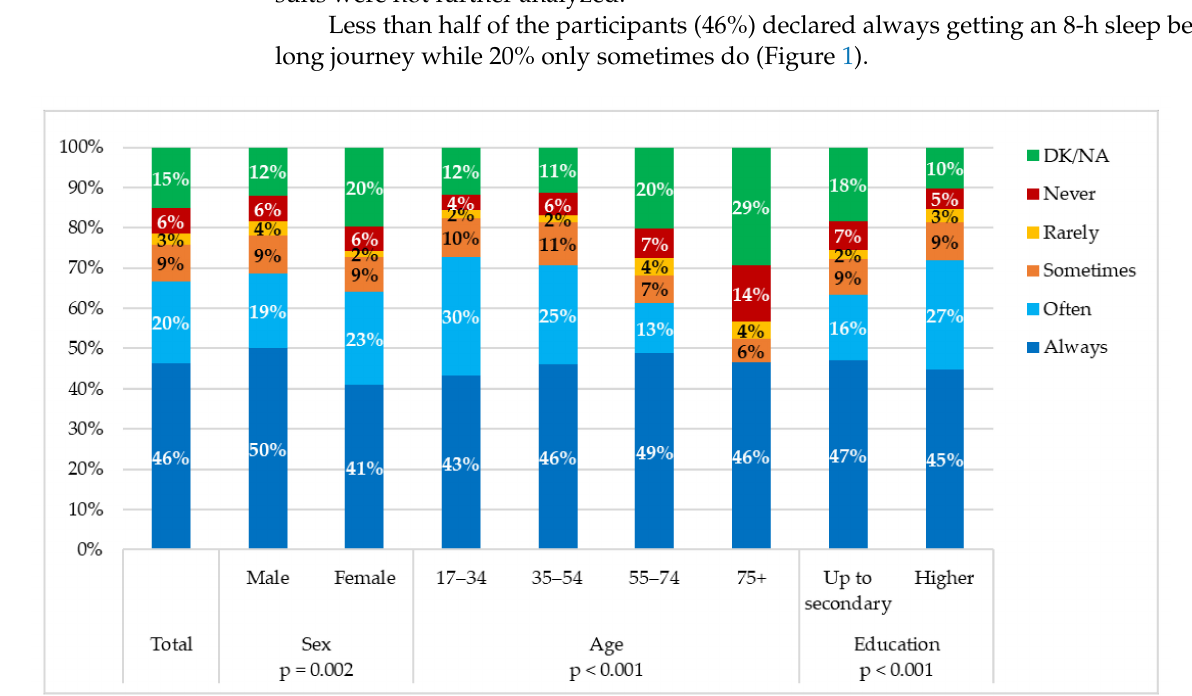
Figure 1. Obtaining 8-h sleep before a long journey in the total sample and by demographic characteristics of participants (question was structured as “How often do you sleep 8 h before a long